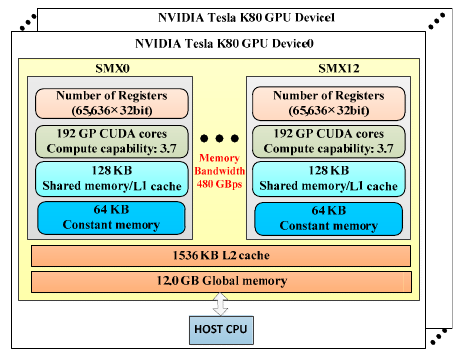
Figure 5. Schematic visualization of NVIDIA Tesla K80 dual ‐ GPU accelerator features.